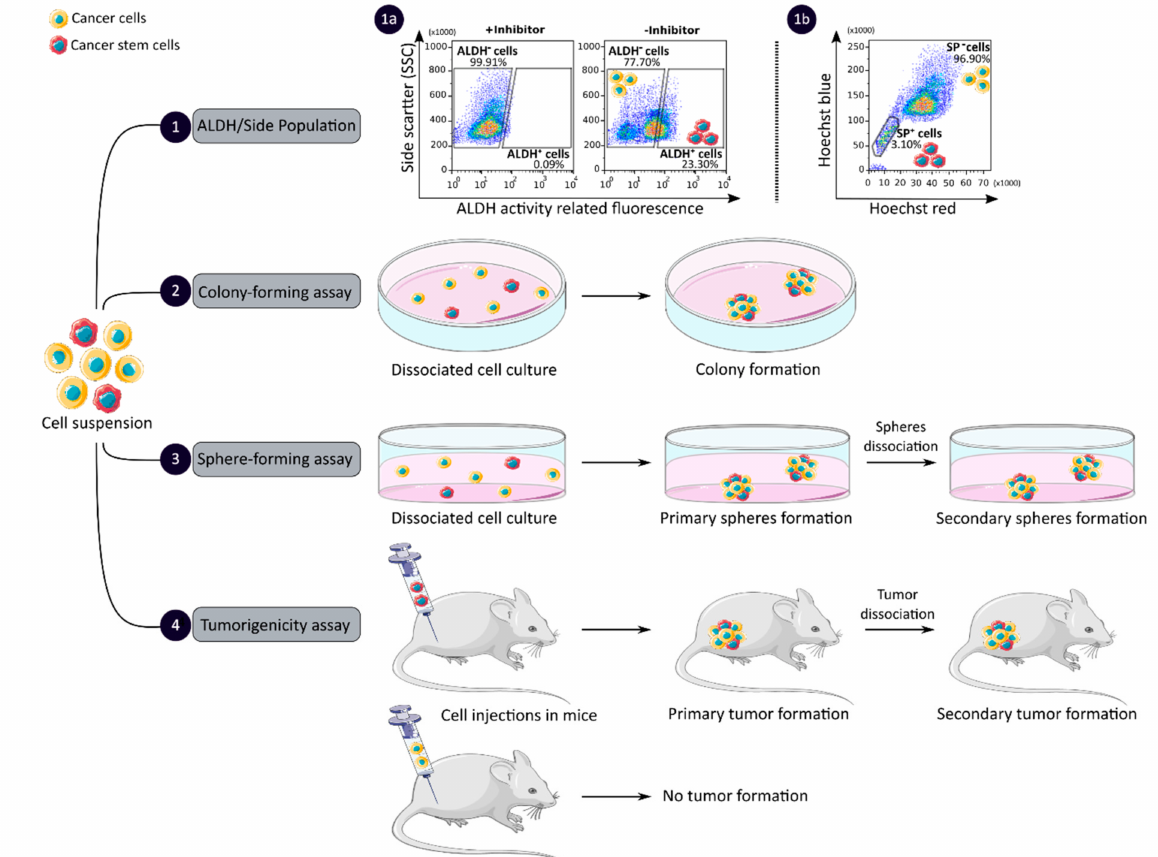
Figure 2. Functional sorting of CSCs due to their specific properties such as enhanced detoxification (1), ALDH (1a) and SP (1b), in vitro self-renewal and differentiation capacity, colony- (2) and sphere-forming (3) assays, and the ability to form tumors in vivo, tumorigenicity assay (4). CSC: cancer stem cell; ALDH: aldehyde dehydrogenase; SP: side